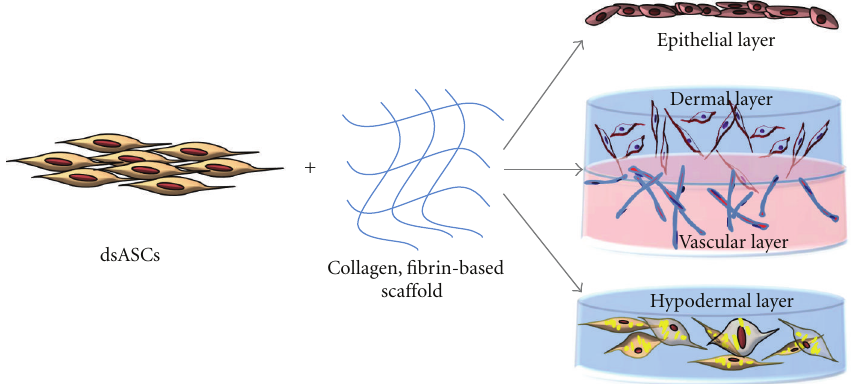
Figure 4: Development of di ff erent layers of skin substitute using dsASCs and hydrogel-based matrices. Epithelial and hypodermal constructs are developed using collagen hydrogel and the vascularized dermal construct using collagen-PEGylated-fibrin-based bilayered